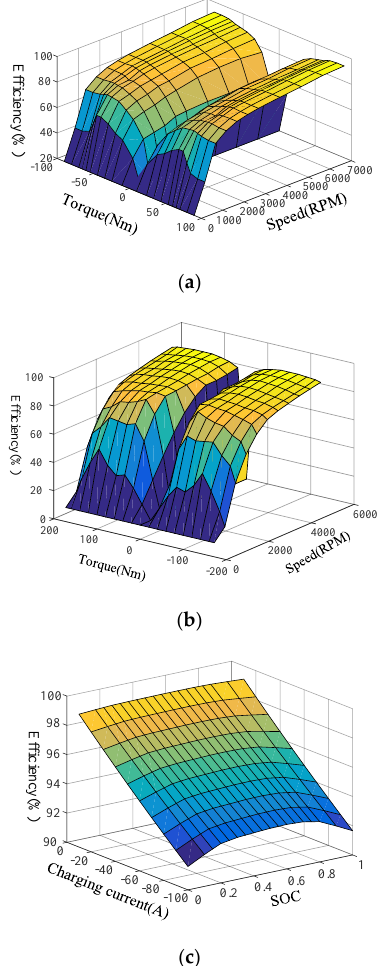
Figure 6. Motor and battery charging efficiency. ( a ) Front motor operating efficiency; ( b ) Rear motor operating efficiency; ( c ) Battery charging efficiency.